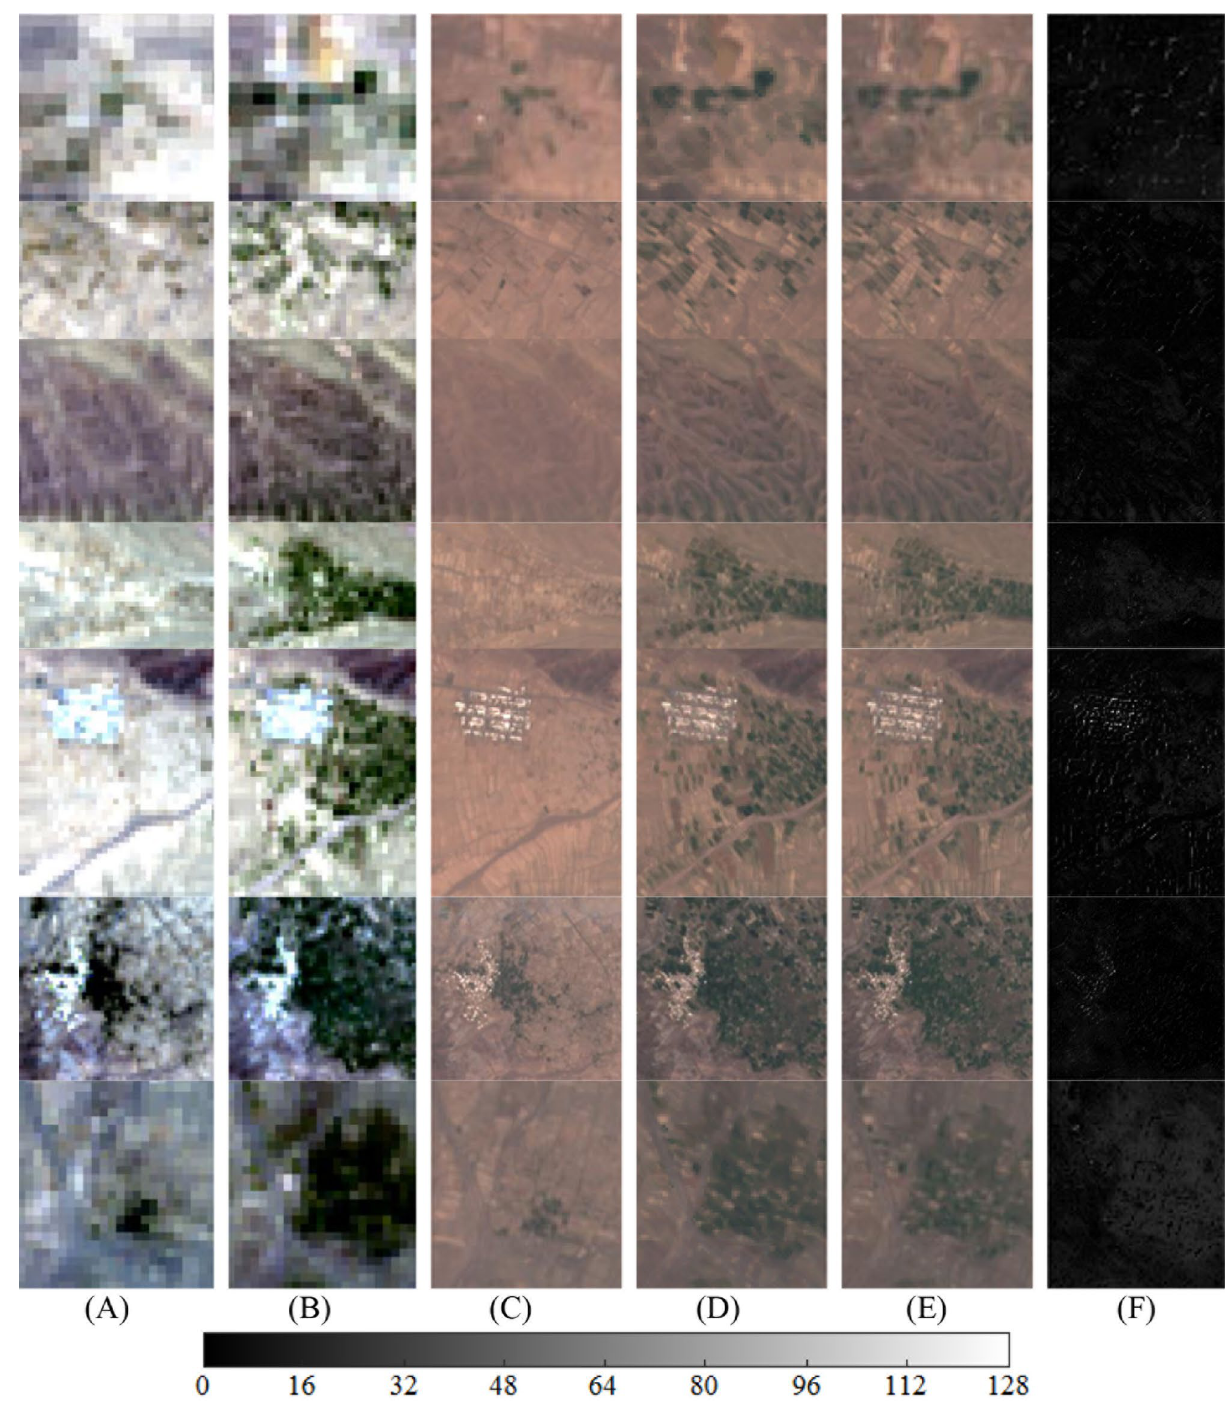
Figure 5. ( A , B ) True color OLI 1 and OLI 2 , ( C ) true color MSI 1 , ( D ) predicted results from the proposed STSR approach, ( E ) true color real MSI 2 , ( F ) intensity difference map between predicted MSI 2 and real MSI 2 . Scale bar shows the difference between predicted and real MSI 2 on a 12-bit Minimizing the spectral variations over each object by introducing a patch-wise covariance parameter as a spatial constraint eliminates the brightness shift. Therefore, the proposed STSR approach smooths extreme differences between spectral responses at different acquisition times, eliminating noise pixels or pixels with a remarkable spectral change in a patch due to temporal change to reduce spectral distortions resulting from changes that are not captured in OLI image. According to Fig. 5F, spectral distortions in the fusion process mainly occur over edge pixels where objects with different spectral responses are adjacent. Spectral mixing is a regular phenomenon over object boundaries,